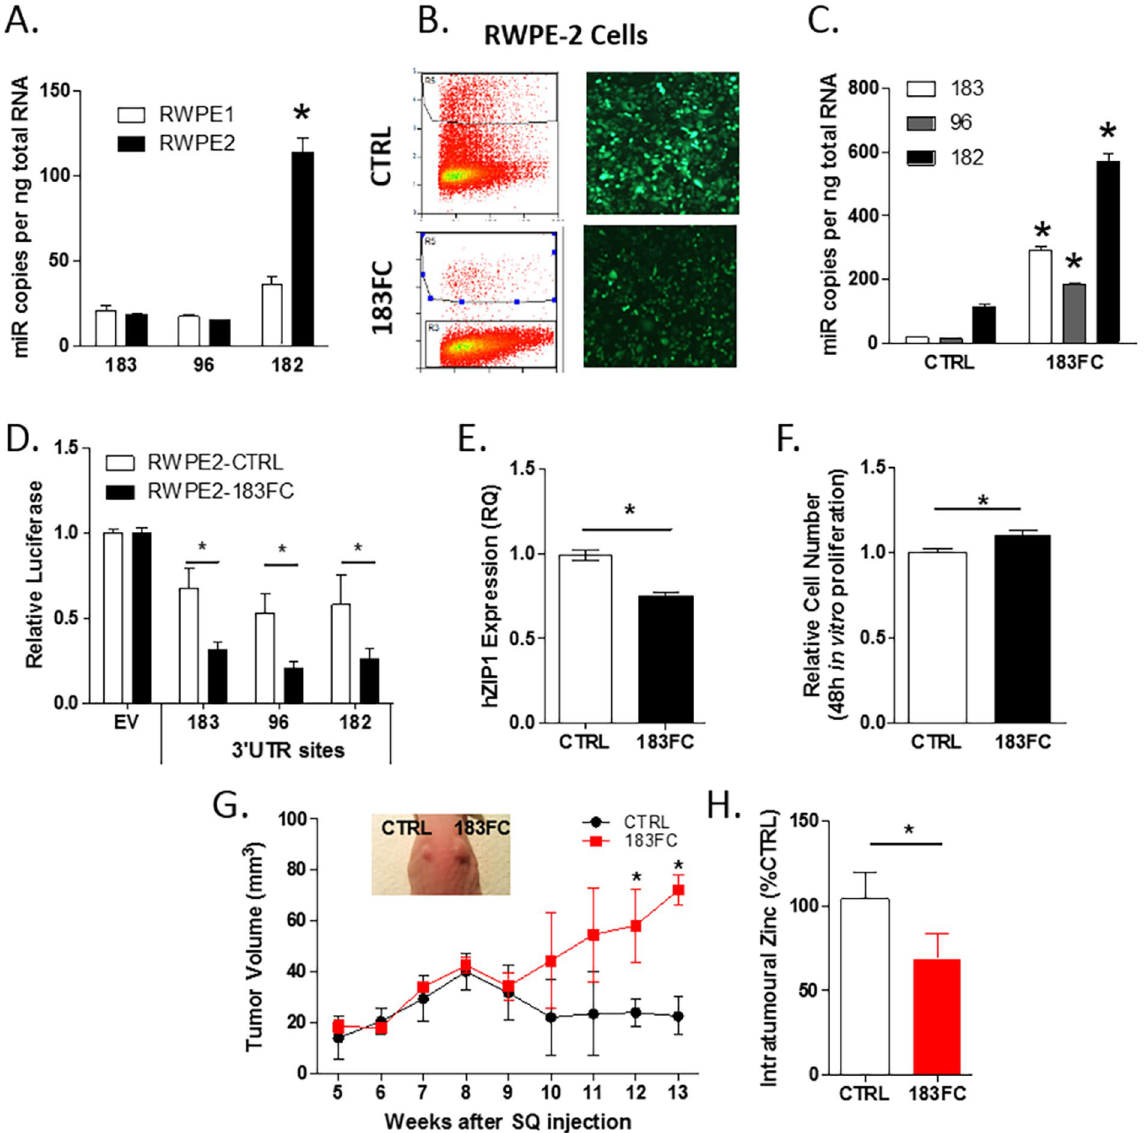
Figure 4. miR-183-FC expression lowered intra-tumoural zinc and increased tumour size in vivo . ( A ) Expression of miRs-183, 96 and 182 in RWPE2 prostate cancer cells compared to benign RWPE1 by RT-qPCR. Relative quantity to RWPE1 cells and normalized to RNU44. ( B ) RWPE2 cells were transduced with CTRL or 183FC lentivirus and FACS sorted. ( C ) Absolute quantitation of miRs-183, 96 and 182 by RT-qPCR analysis, and ( D ) respective reduction of miR-specific luc-3 ′ UTR plasmids compared to empty vector (EV) after 24 hours in RWPE2-CTRL and RWPE2-183FC cells (mean and SEM shown, n = 2). ( E ) hZIP1 gene expression normalized to HPRT in CTRL and 183FC RWPE2 cells. ( F ) 48 hour cell proliferation assay comparison between CTRL and 183FC RWPE2 cells in vitro . Bar graph shows mean with SEM for n = 3 experiments. ( G ) tumor volume of RWPE2-CTRL and 183FC xenografts in nude mice; n = 3 grafts for each cell type. Mean with SEM at each week. * p < 0.05 for unpaired Student’s two-sided t-test CTRL versus 183FC. ( H ) Zinc levels in the RWPE2-CTRL and 183FC tumours by Quantichrome assay (n = 3). Unless otherwise specified, mean and SEM (error bars) are shown on the graphs with statistics by paired Student’s 2-sided t-test of experimental replicates, * p <